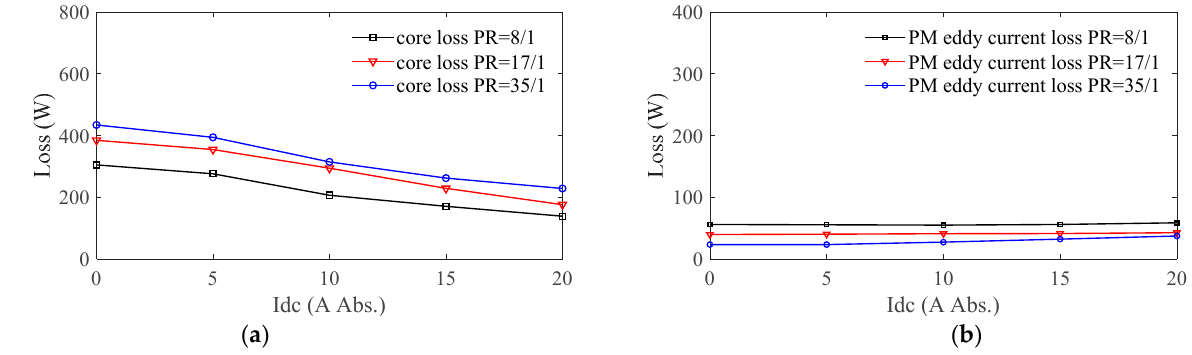
Figure 9. On–load electromagnetic torque and cogging torque waveforms of the proposed DR- HAFPMVMs with different PRs. ( a ) On–load electromagnetic torque with PR of 8/1. ( b ) On–load electromagnetic torque with PR of 17/1. ( c ) On–load electromagnetic torque with PR of 35/1. ( d ) Cogging torque of three machines.